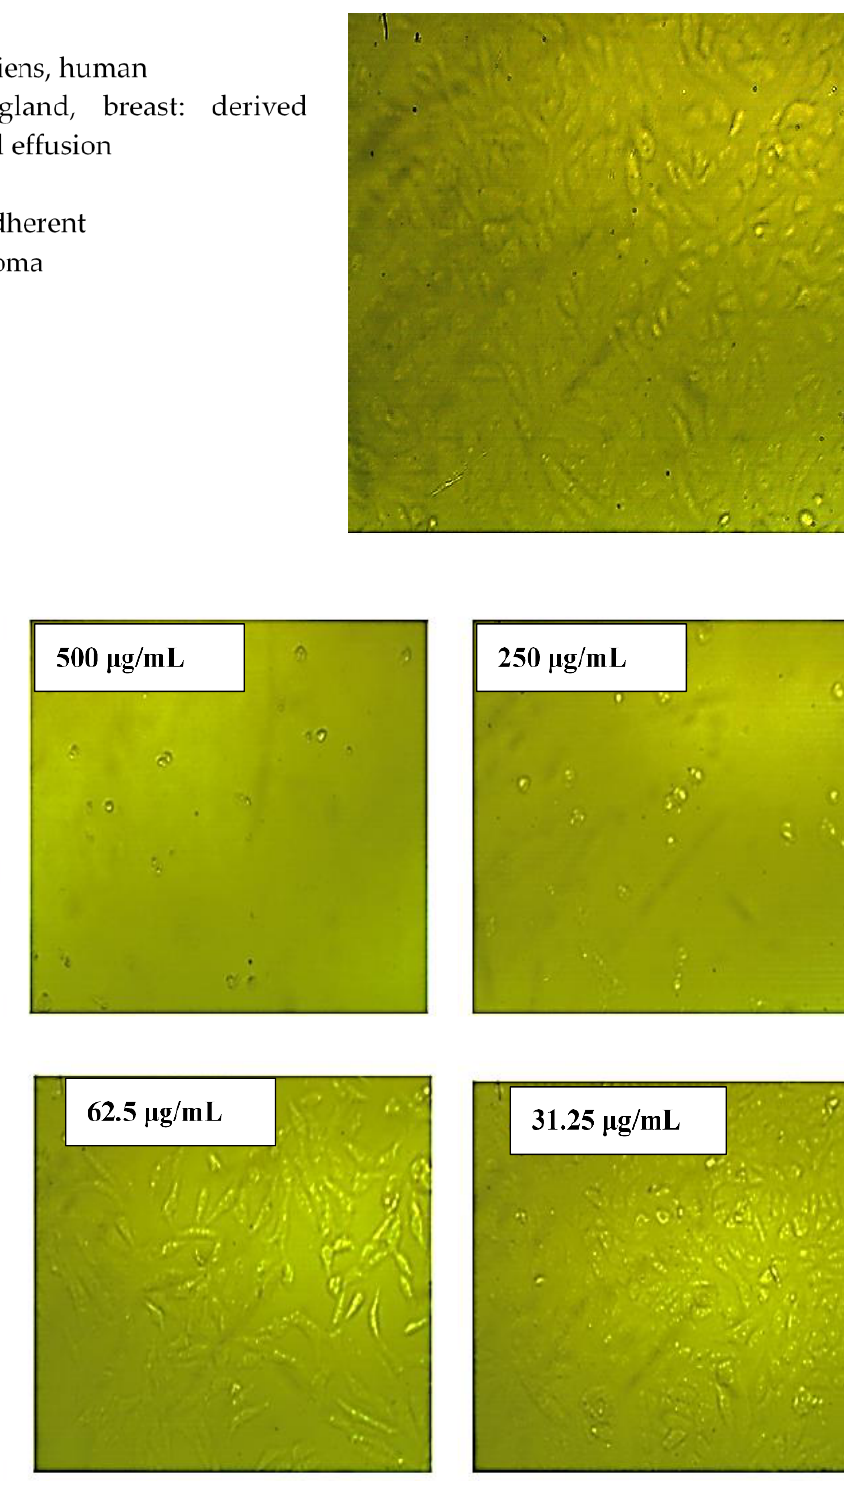
Figure 10. Microscopic images of Mcf7 cancer cells after treatment with various concentrations of Co 3 O 4 NPs synthesized using rosemary leaf extract.